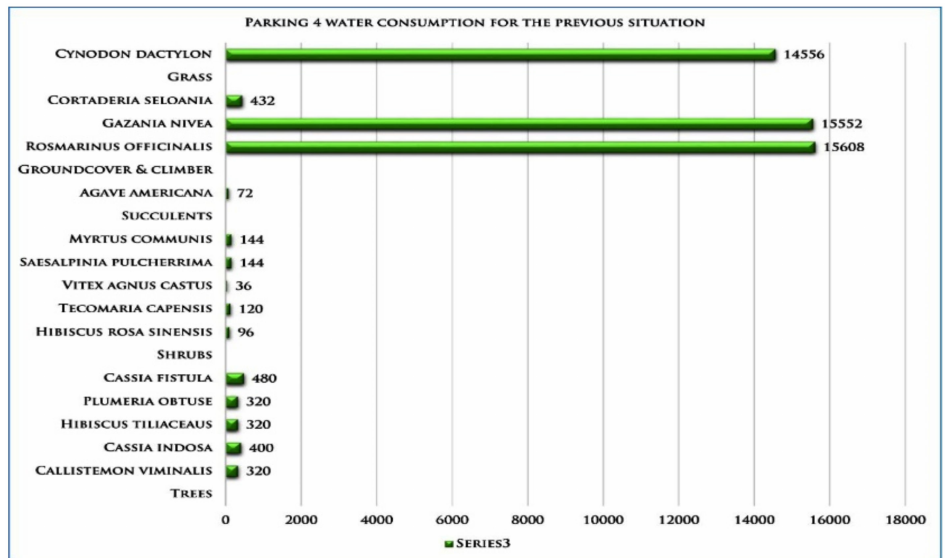
Figure 15. Experiment 2 water consumption quantity for previous status. Previous tender softscape design water consumption (Details in Table A2).